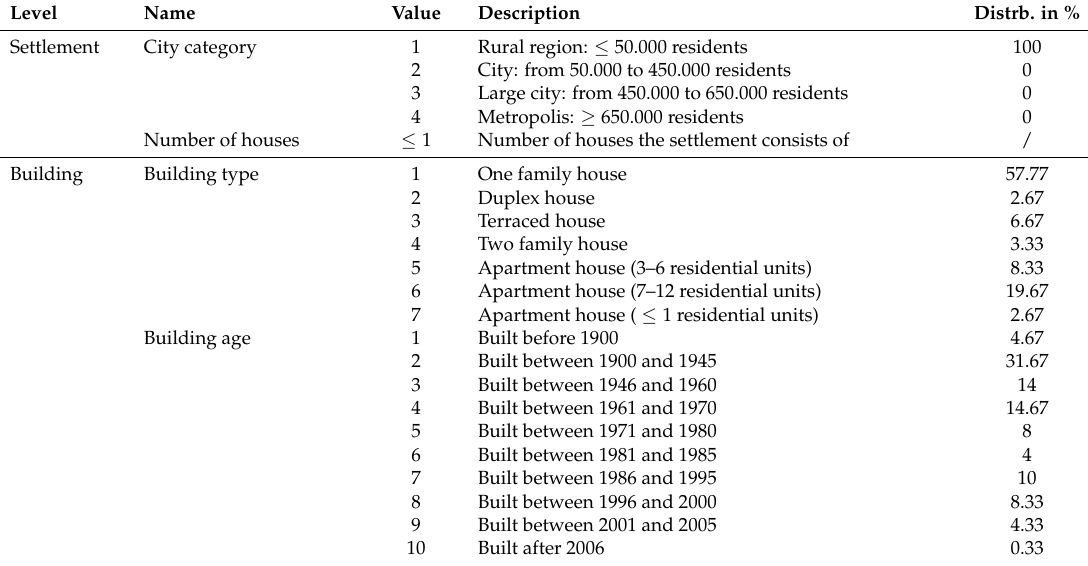
Table A1. Input Parameters at the level of settlement, building and